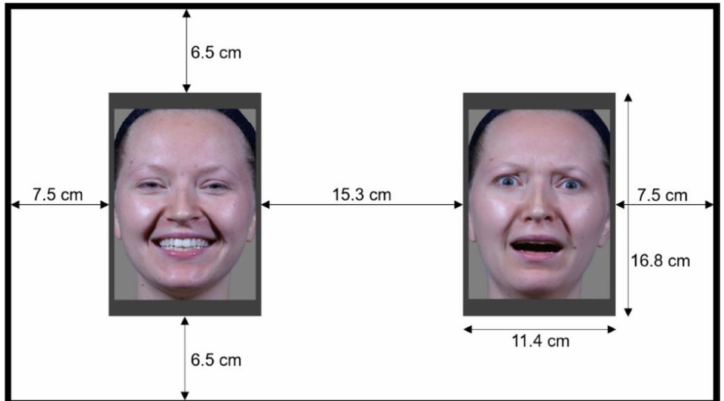
Figure 3. The dimensions of stimuli in relation to the